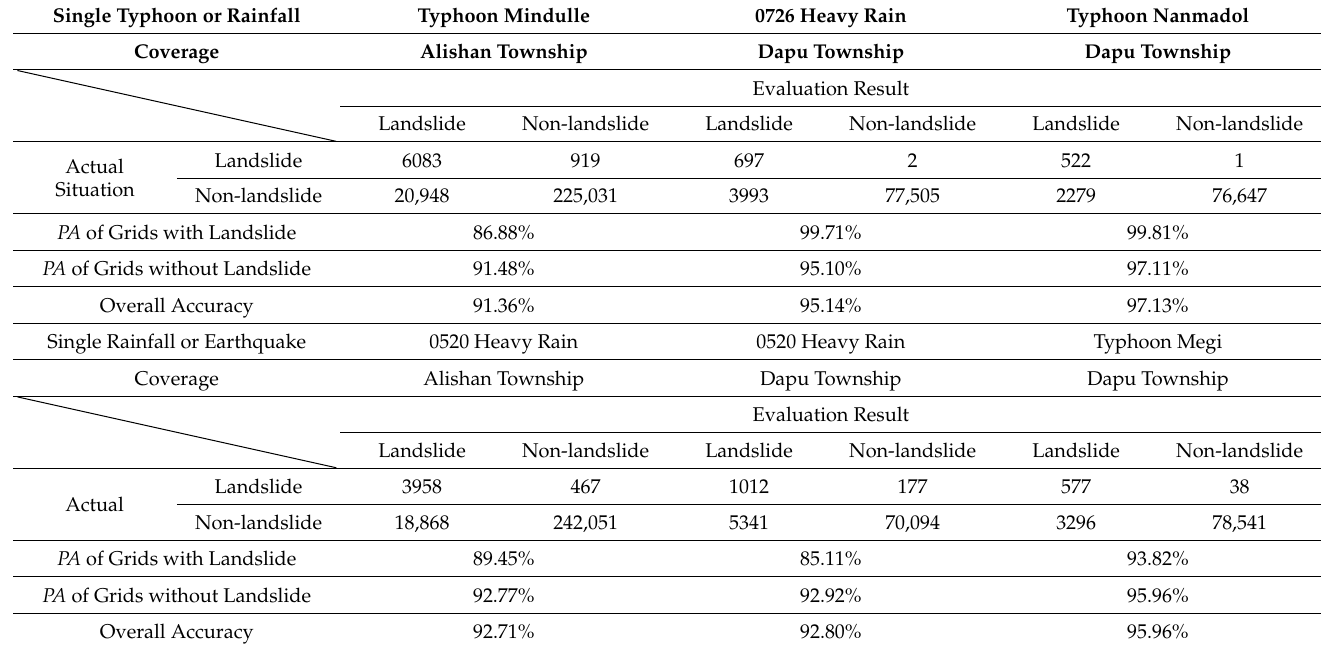
Table 8. Evaluation accuracy of single rainfall-induced landslide potential.